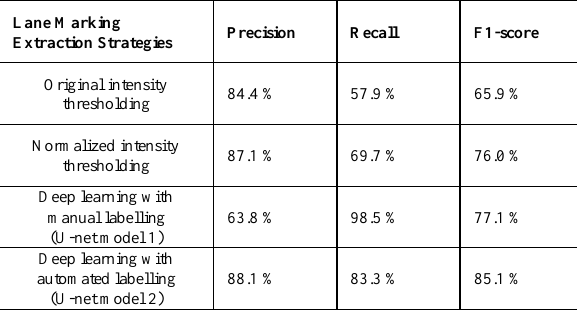
Table 5. Performance metrics in concrete pavements for lane marking extraction strategies